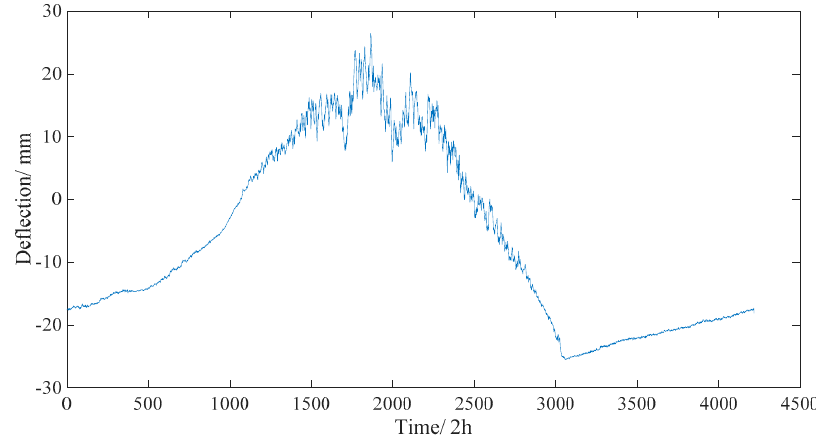
Figure 16. Long-term monitored deflection data of one year (averaged every two hours).